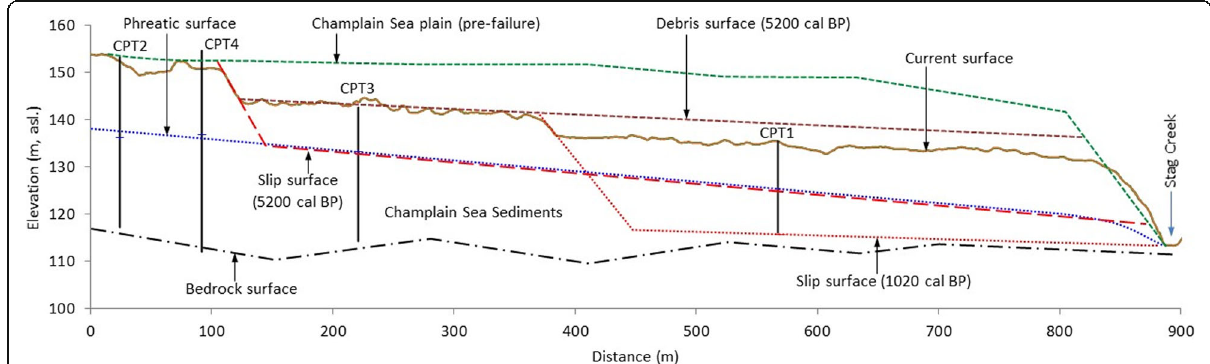
Fig. 8 Cross-section of the Low landslide (location shown in Fig. 7). The CPT locations are approximate projections to the centerline. (Vertical exaggeration: